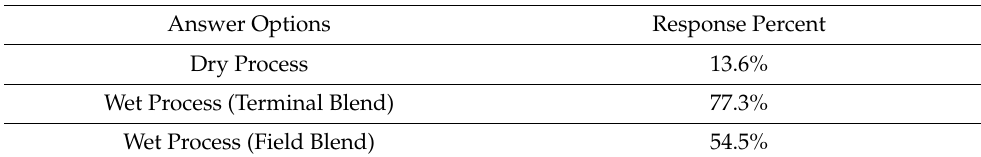
Table 13. Types of processes used by states to incorporate GTR or CR in asphalt mixes.